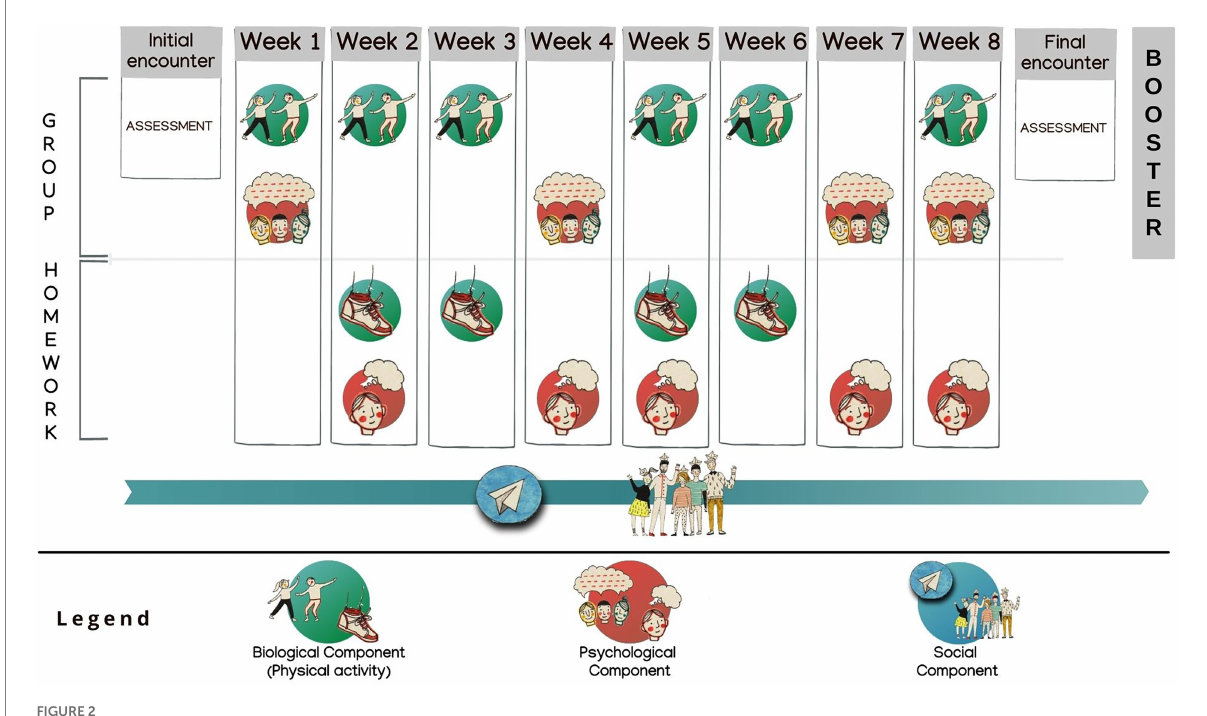
FIGURE 2 Overview of the ESPRIMO bio-psycho-social